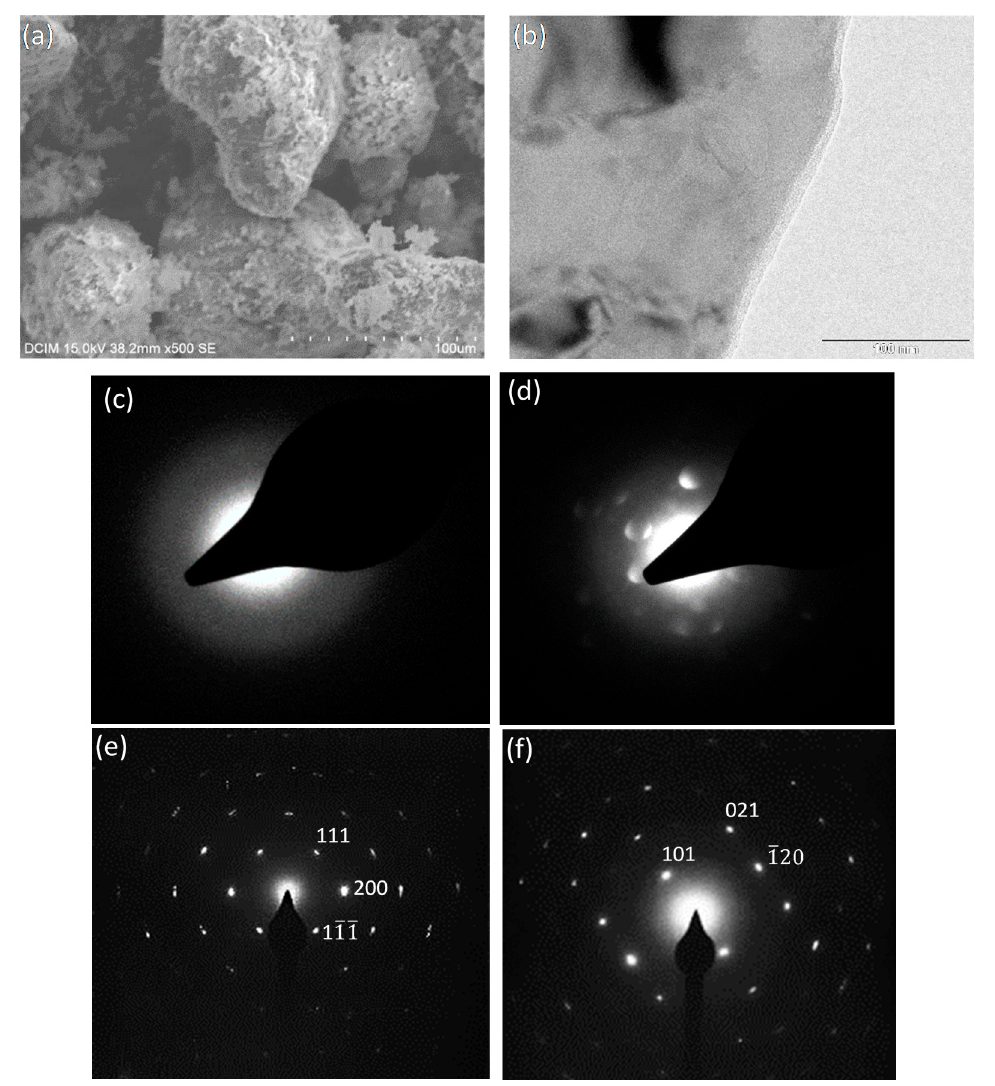
Figure 3. ( a ) Al / AlN powder ( b ) TEM bright field (BF) micrograph of ( a ) Al / AlN interface; ( b ) Detail of Figure 3. ( a ) Al/AlN powder ( b ) TEM bright field (BF) micrograph of ( a ) Al/AlN interface; ( b ) Detail AlN coating; ( c ) Al / AlN amorphous ED; ( d ) Al / Al nanocrystal ED; ( e ) Al / AlN cubic ED; ( f ) Al / AlN of AlN coating; ( c ) Al/AlN amorphous ED; ( d ) Al/Al nanocrystal ED; ( e ) Al/AlN cubic ED; ( f ) Al/AlN hexagonal hexagonal ED.